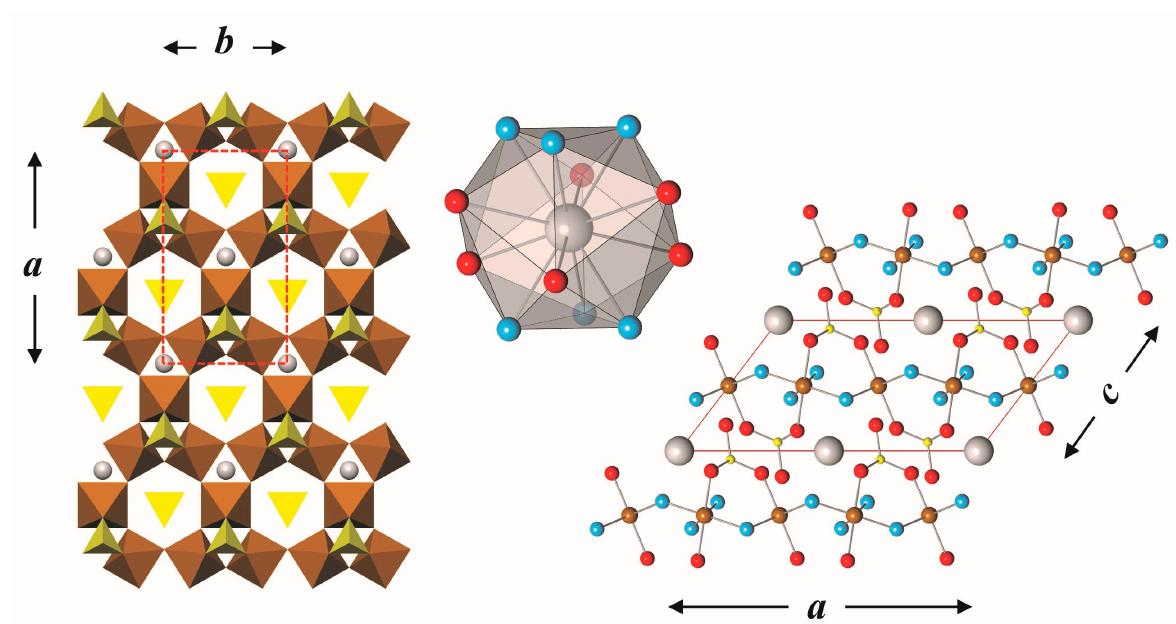
Figure 1. The structure of Na/K/Ag jarosite (monoclinic, space group C 2/ m ). Left: A polyhedral representation of the B layer of edge-sharing Fe(OH) 4 O 2 octahedra and an overlying SO 4 . . . A (Na, K, Ag) layer. Right: Ball-and-spoke diagram showing the alternating layers of Fe(OH) 4 O 2 octahedra (Fe brown) and SO 4 tetrahedra (S yellow). Oxygen atoms of hydroxyl groups are shown in pale blue, other oxygen atoms are red. Na/K/Ag atoms are grey. The apical oxygen of the SO 4 tetrahedron (S=O) receives three hydrogen bonds from three hydroxyl groups. The three oxygen O donor (-H) . . . O acceptor distances are ~2.75 Å (two) and ~2.95 Å (one). H atoms are omitted for clarity. Centre: A -site atoms (Na/K/Ag) occupy large dodecahedral cavities within the polyhedral framework and are located in the SO 4 layer. (b) The coordination polyhedron of Na/Ag-O 6 (OH) 6 . Projections of the jarosite unit cell are shown in red.